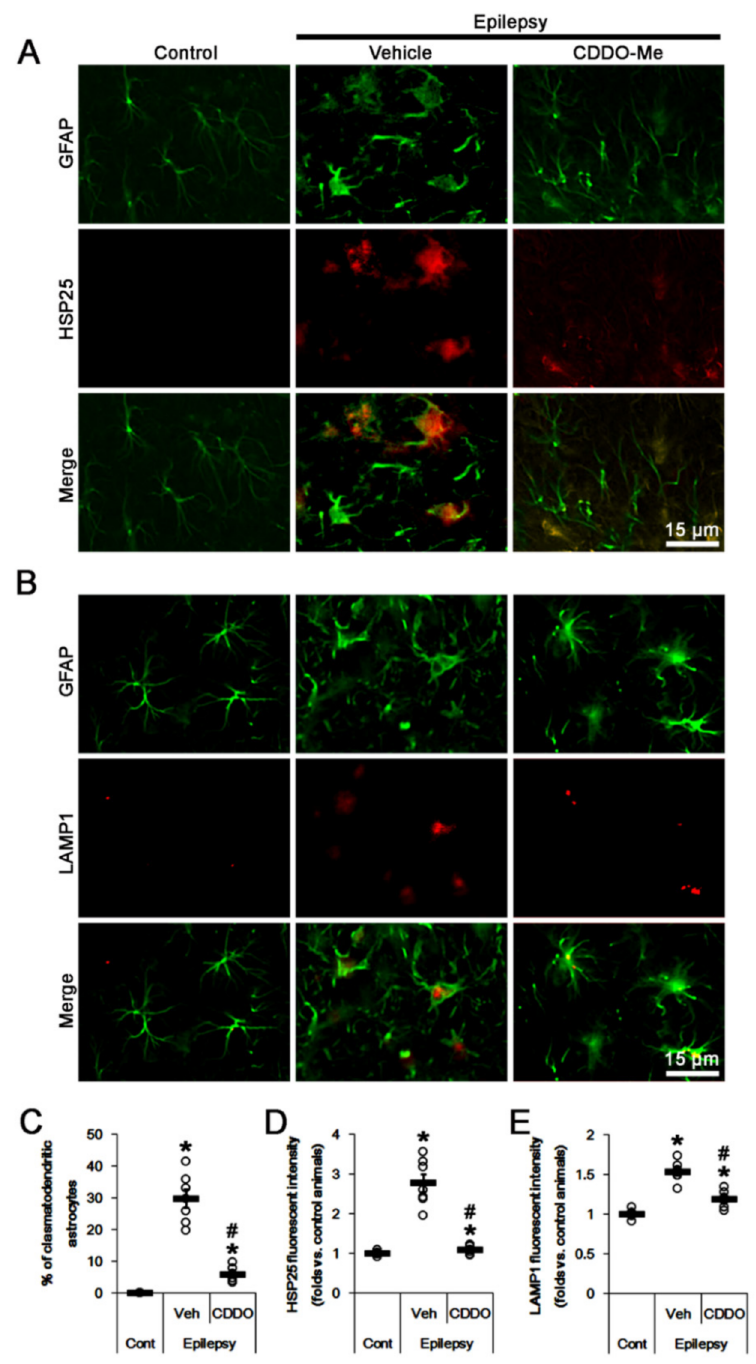
Figure 1. Effects of CDDO-Me on heat shock protein 25 (HSP25) and lysosomal-associated membrane protein 1 (LAMP1) expressions in CA1 astrocytes of control and epileptic rats. As compared to control animals (Cont), HSP25 and LAMP1 expressions are upregulated in CA1 astrocytes in epileptic rats. CDDO-Me reduces the increased HSP25 and LAMP1 expressions in CA1 astrocytes, as compared to vehicle (Veh). ( A , B ) Representative photos demonstrating astroglial HSP25 ( A ) and LAMP1 ( B ) expressions in CA1 astrocytes. ( C – E ) Quantifications of the fraction of clasmatodendritic astrocytes in total CA1 astrocytes ( C ), HSP25 expression ( D ) and LAMP1 fluorescent intensity ( E ) in CA1 astrocytes. Open circles indicate each value. Horizontal bars indicate the mean value. Error bars indicate SEM (*, # p < 0.05 vs. control and vehicle-treated epileptic rats, respectively; n = 7,